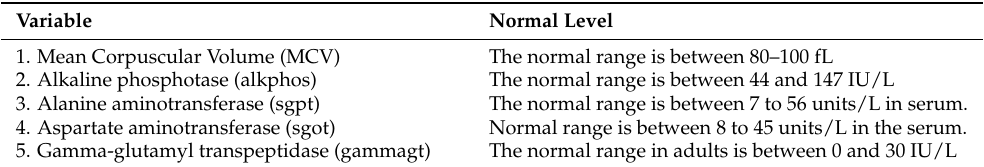
Table 2. Measured variables in the dataset to define the liver